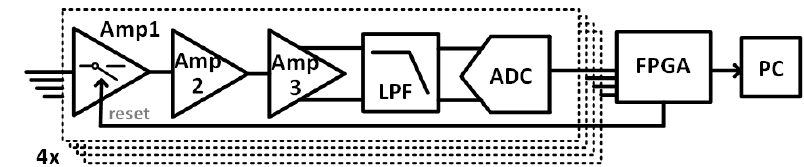
Figure 4. Block diagram of the hardware system employed in this